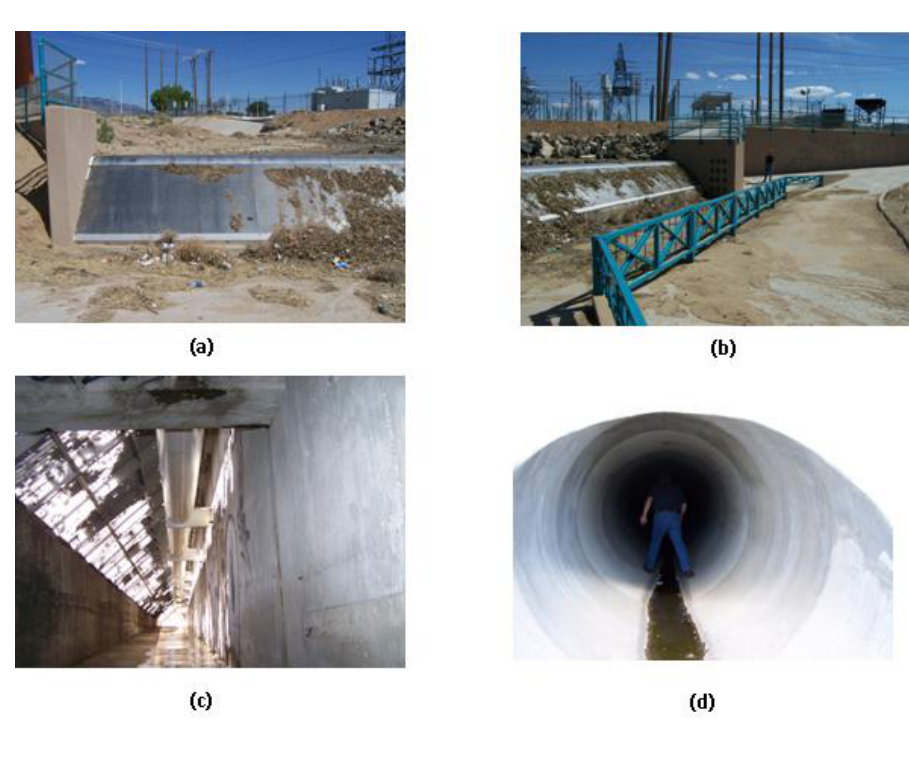
Figure 2. Different components of a debris removal structure with Coanda-effect